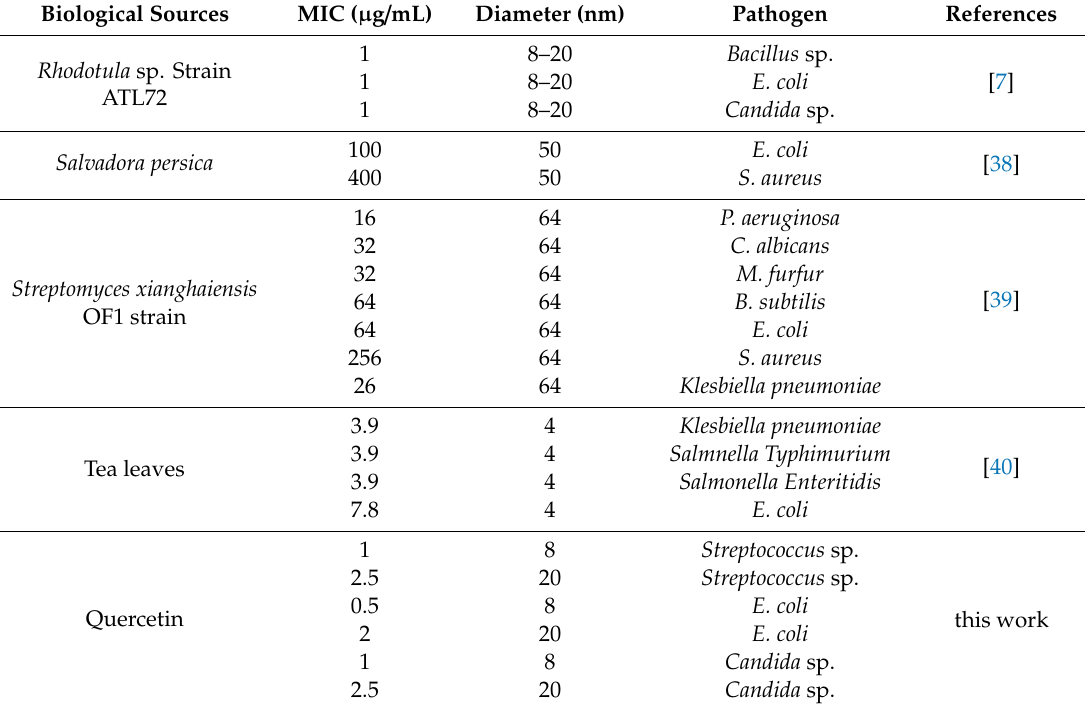
Table 3. Comparison of MIC values of “green” AgNPs from di ff erent biological sources against di ff erent